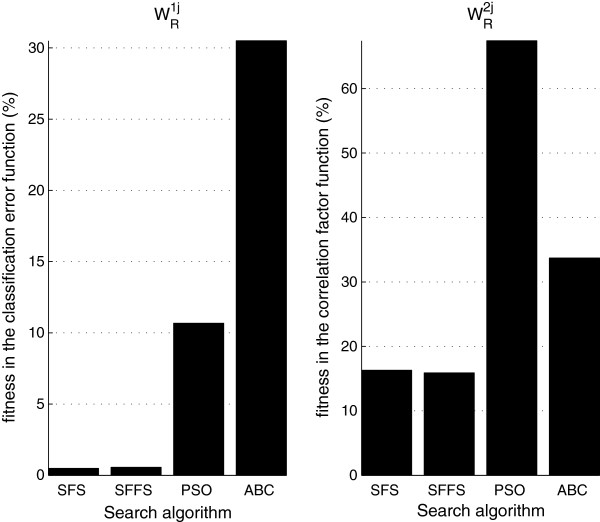
Comparison of the fitness value reached with each of the eight treatment alternatives during the optimization search. The sequence of algorithms in each figure was selected according to the descending order of fitness.